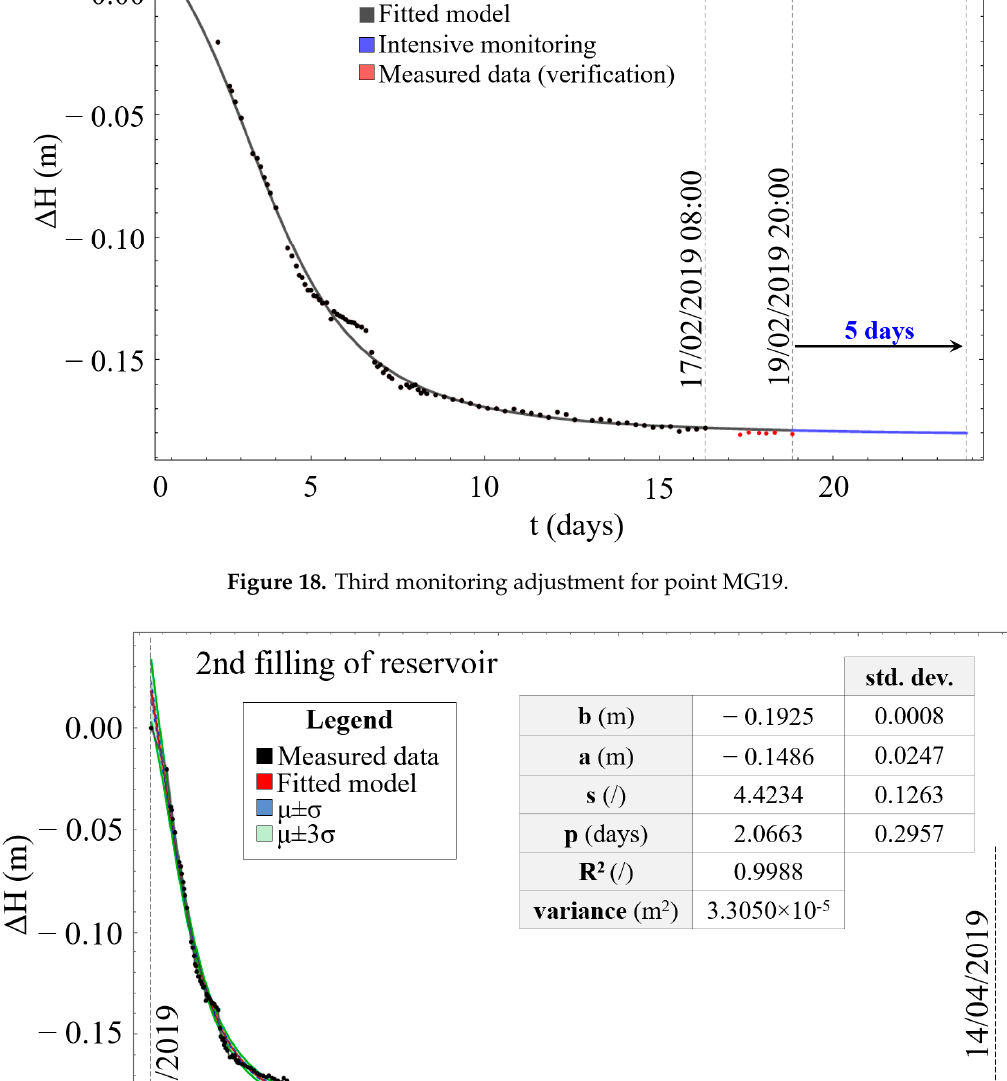
Figure 17. Second monitoring adjustment for point MG19.